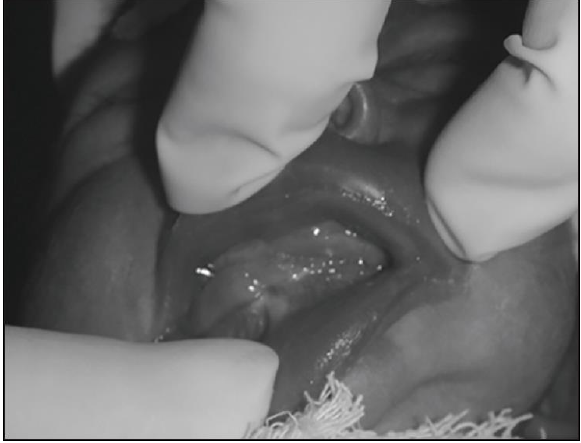
Figure 1: Complete alveolar fusion